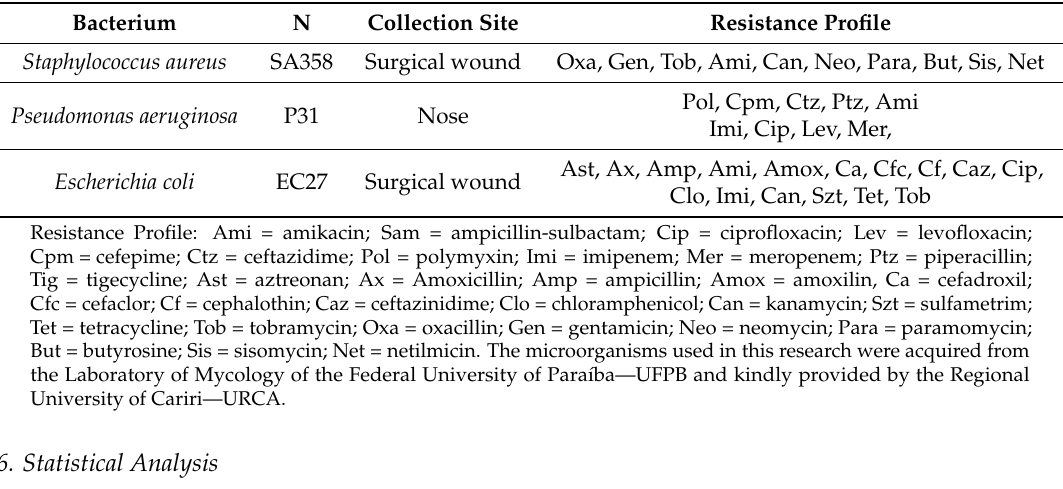
Table 3. Resistance profile of the bacteria used in the